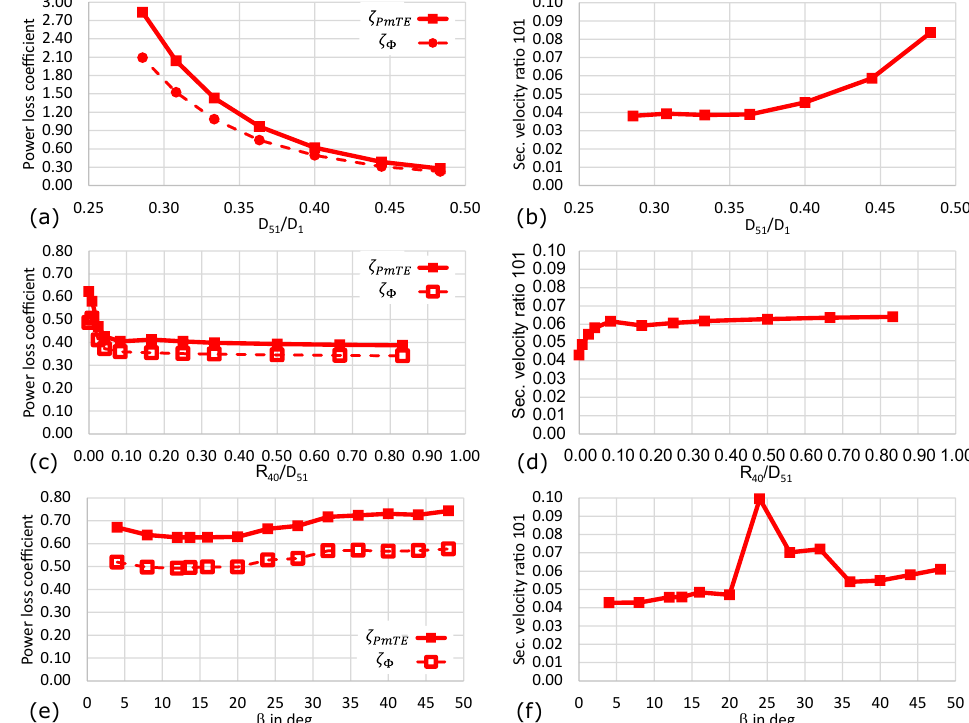
Figure 6. Line plots of the power loss coefficients and secondary velocity ratios of basic model. Charts ( a , b ) show the effect of a variation in the diameter ratio D 51 / D 1 , ( c , d ), the fillet radius R 40 / D 51 , and ( e , f ) of the diffuser angle β